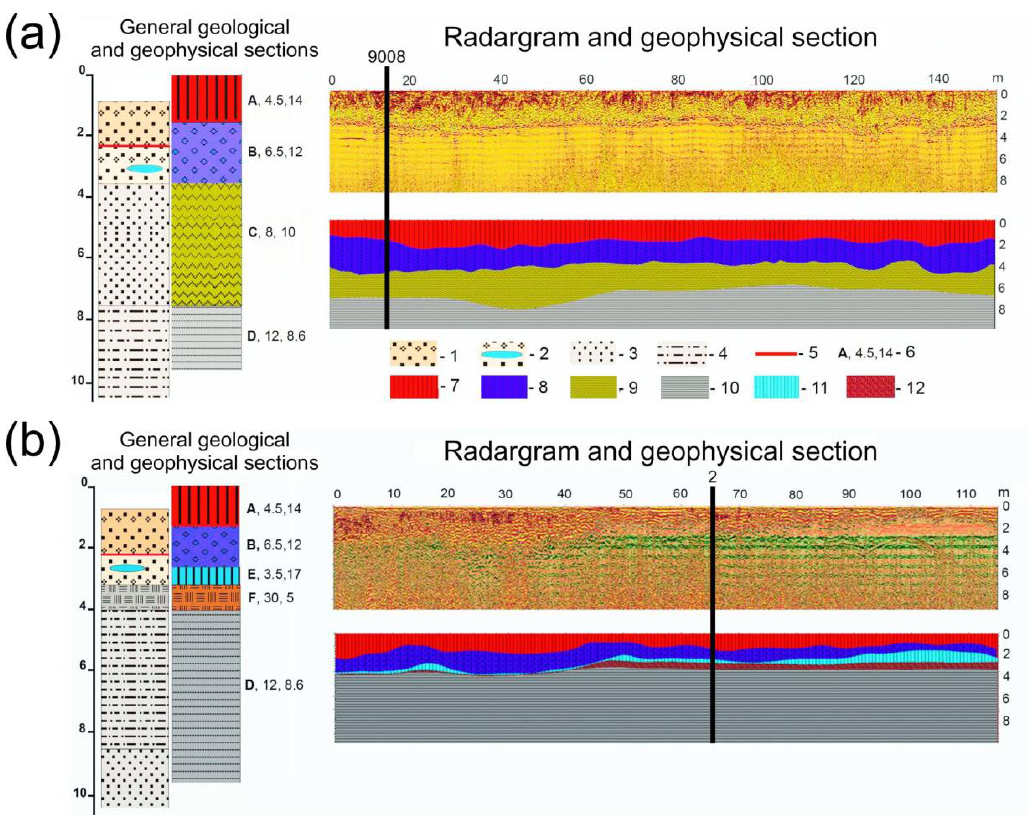
Figure 3. Etalons no. 1 ( a ) and no. 2 ( b ): coupling of geological sections disclosed by boreholes (9008